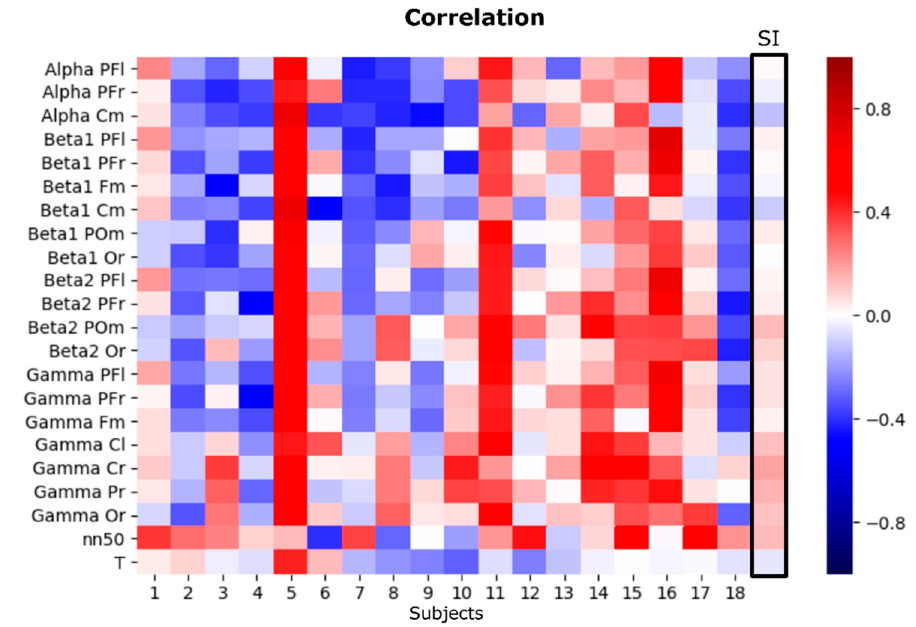
Figure 7. SD and SI correlation of the 22 features of the computational model of study and the emotional valence dimension. PFr: Pre-Frontal right. PFl: Pre-Frontal left. Fm = Frontal midline. Cm = Central midline. Cl = Central left. Cr = Central right. Pr = Parietal right. Or = Occipital right. POm = Parietal-occipital midline.